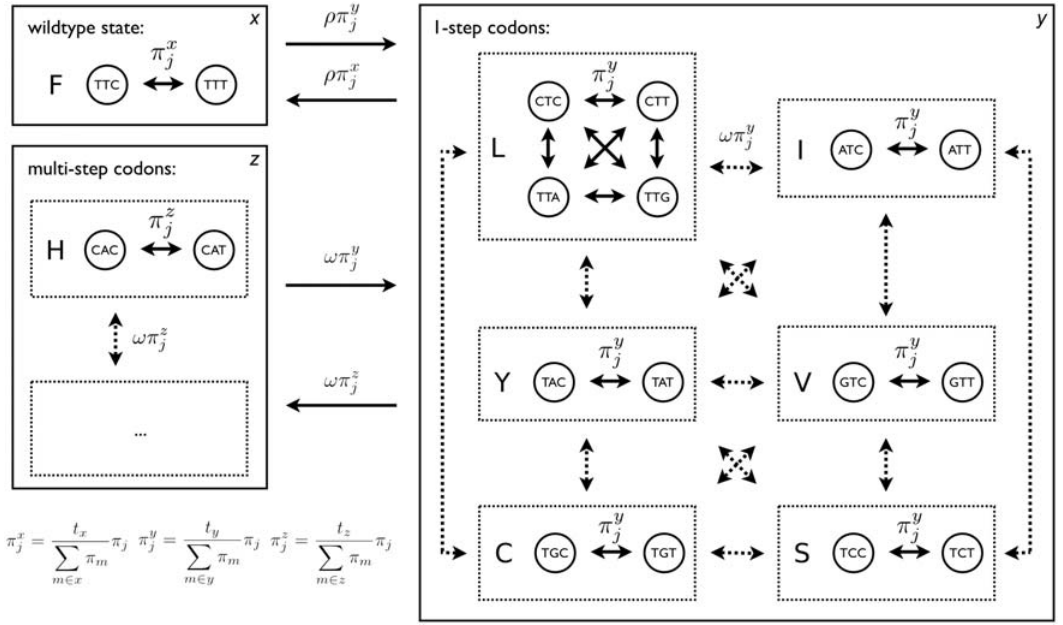
Figure 1. Codon model of amino acid toggling. The immune escape and reversion model has three classes of codons: codons encoding the wild type amino acid (class x); codons separated from the wild type by a single nucleotide substitution (y); and codons separated from the wild type by more than one substitution (z). In the example shown, phenylalanine (F) is the wild type amino acid. Rates of substitution between F and each of the six amino acids within one nucleotide substitution of F or from these amino acids back to F are affected by the parameter r , the amino acid toggling rate. All other non-synonymous substitutions have a multiplier v instead of r . Rates of all substitutions depend on the frequency parameters , where c represents the codon class. The p c parameters take account of the codon bias estimated across the entire alignment and free parameters p c j j t c which describe the proportion of time spent by the site in each of the three codon classes.